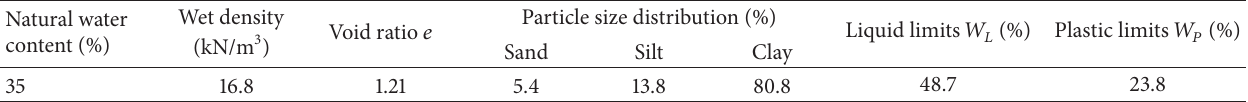
Table 1: Physical properties of clay.